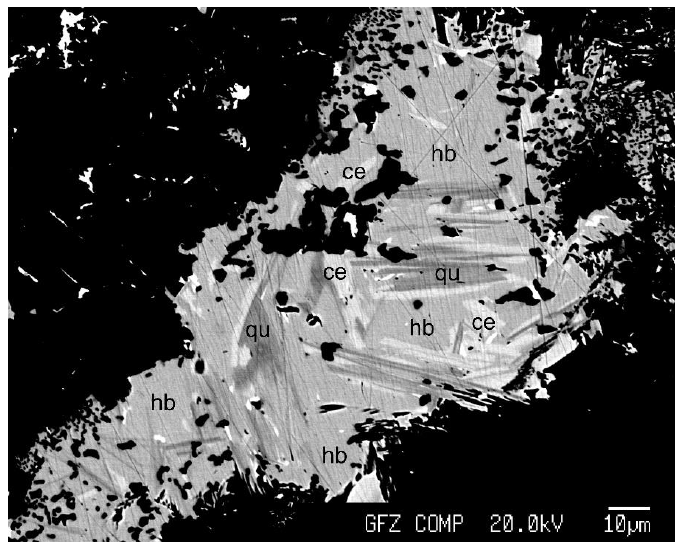
Figure 1. Back-scattered electron (BSE) image of type-I cerromojonite intergrown with hansblockite and quijarroite, forming an angular network-like intersertal texture. Abbreviations: ce = cerromojonite, hb = hansblockite, qu = quijarroite.